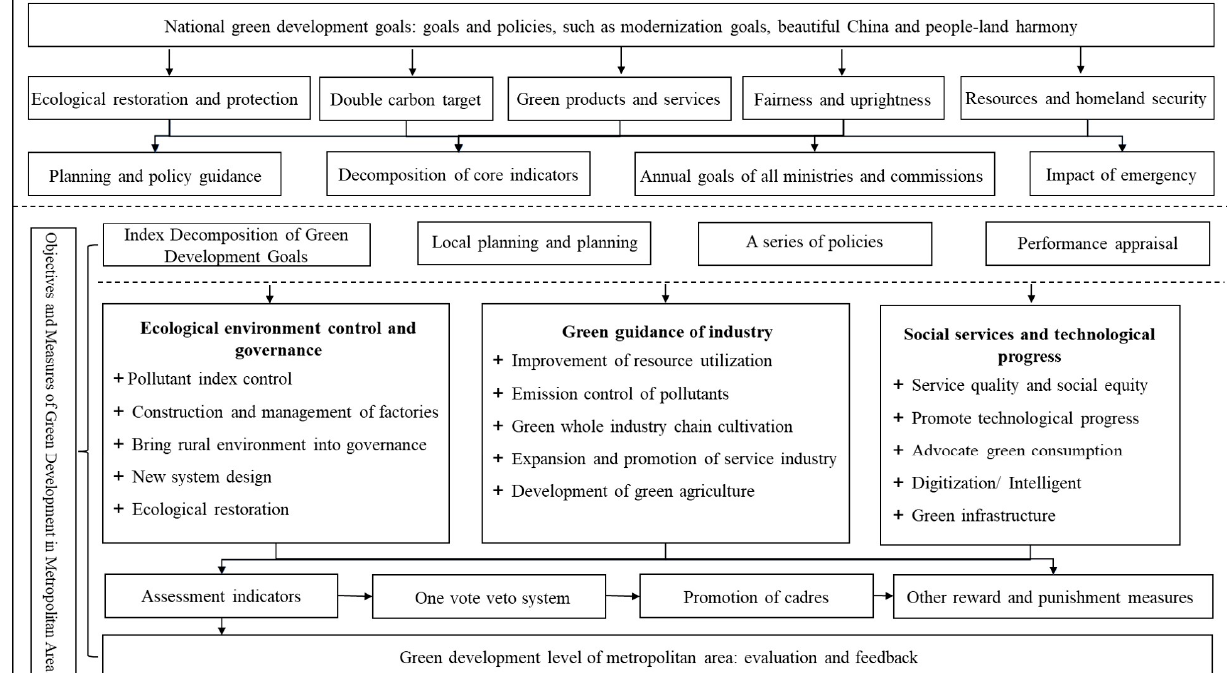
Figure 3. The “Top ‐ Down” Systematic Green Development Management and Control Driving Mode of the